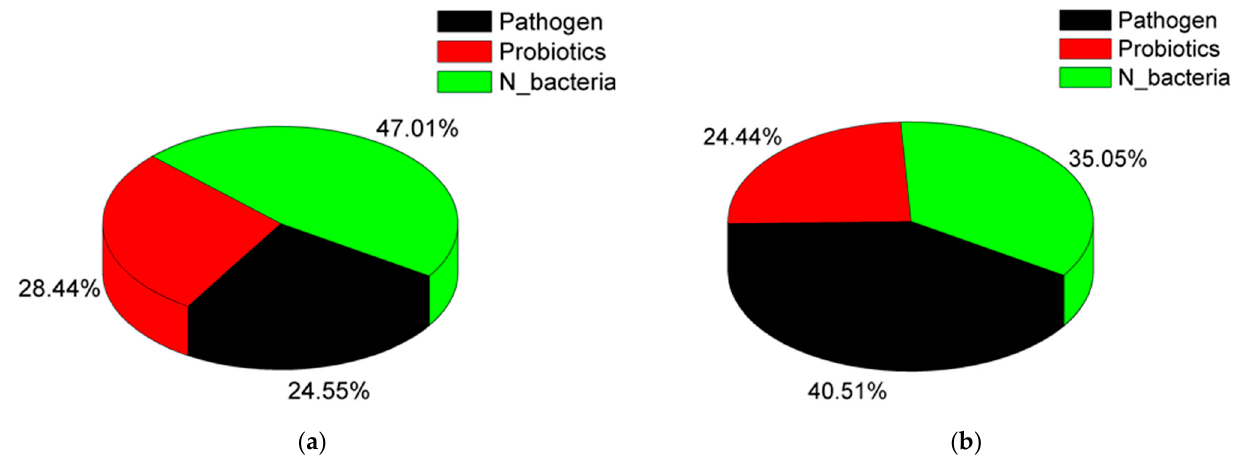
Figure 5. The average percentage is known bacteria cultivable in aquaponic systems for eight weeks ( a ) without treatment and ( b ) with additional nutrition. (n =